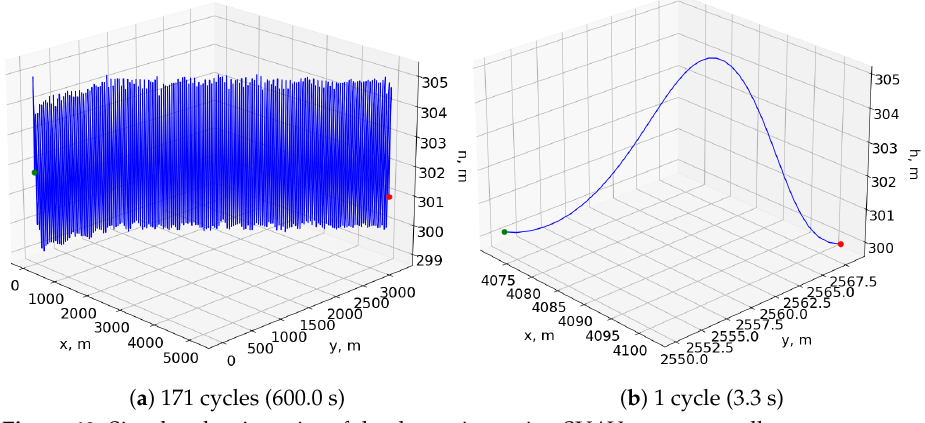
Figure 13. Simulated trajectories of the dynamic soaring SUAV neurocontroller.